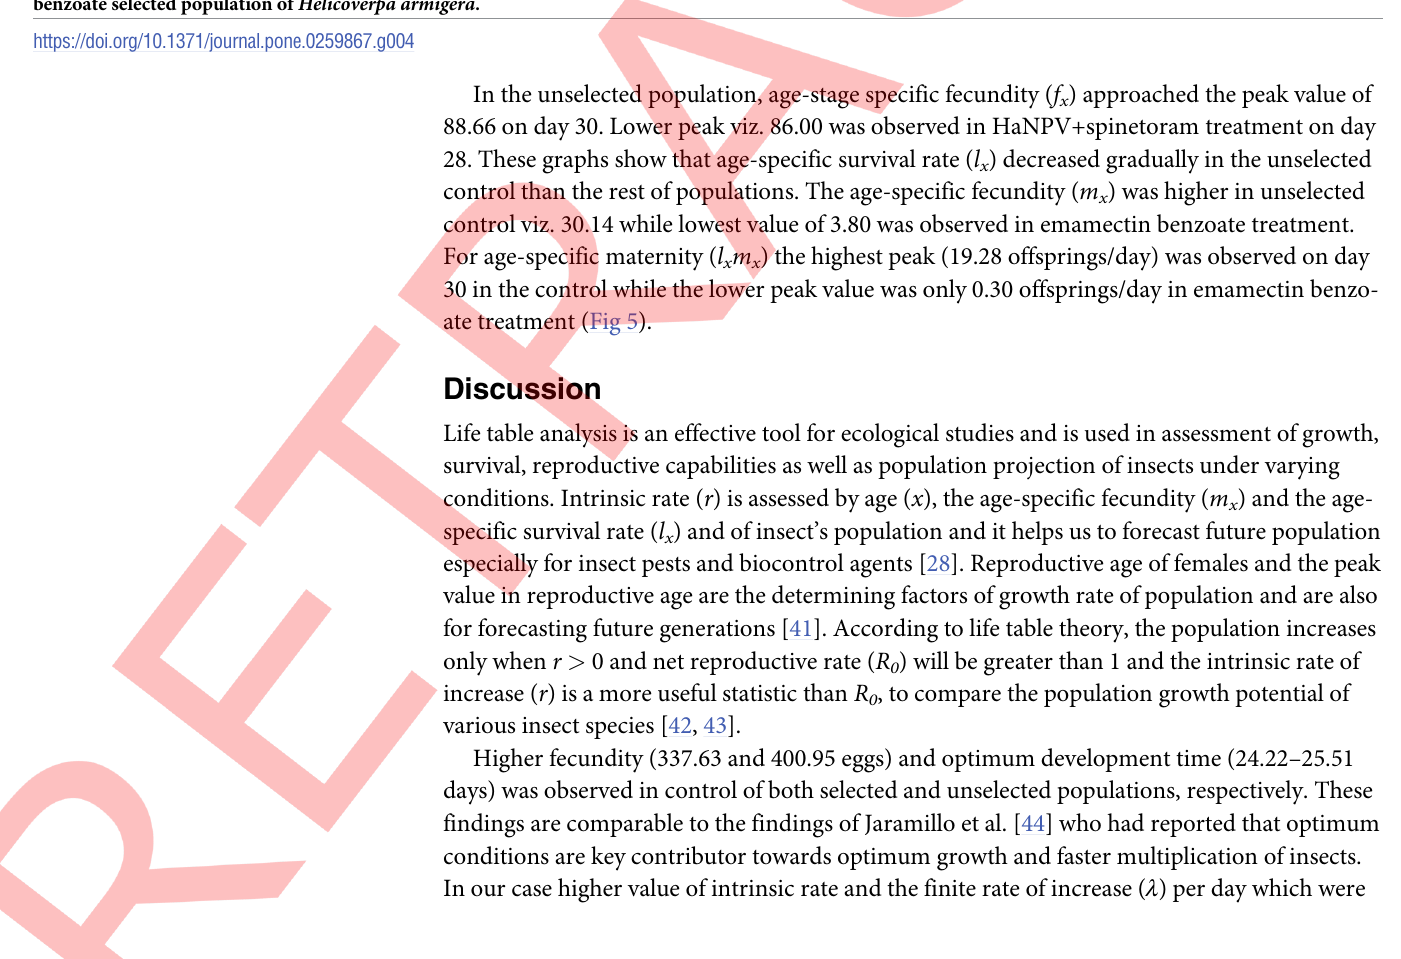
), age stage specific maternity ( m ) and their product in emamectin x x